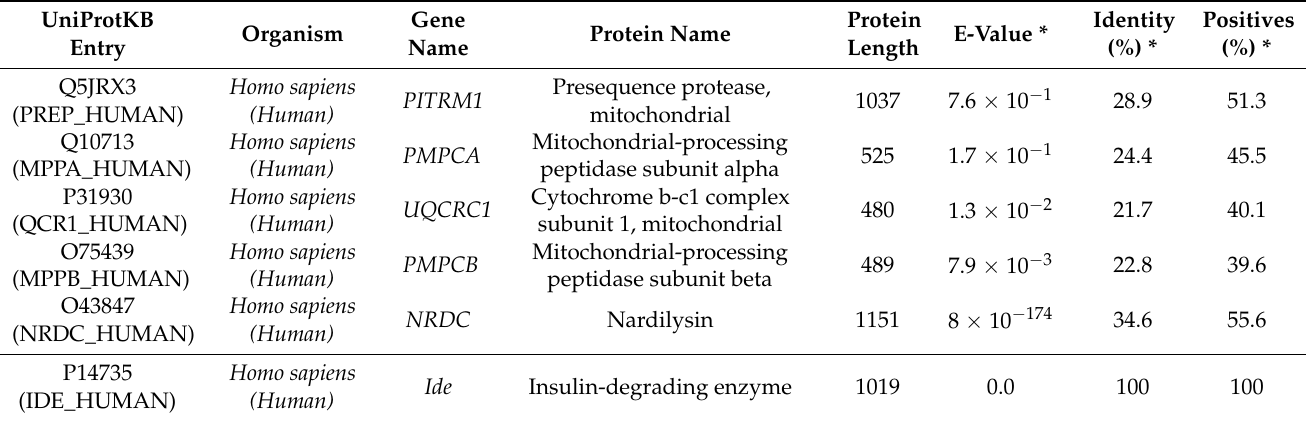
Table 2. Human paralogs of